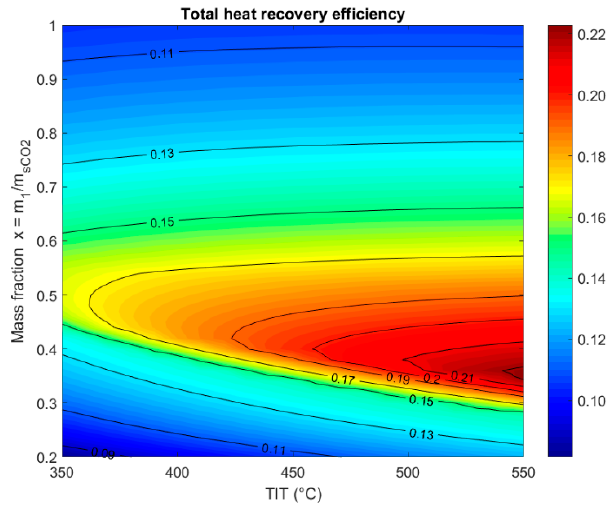
Figure 7. Variation of η TOT with TIT and x for the single flow split with a dual expansion cycle.